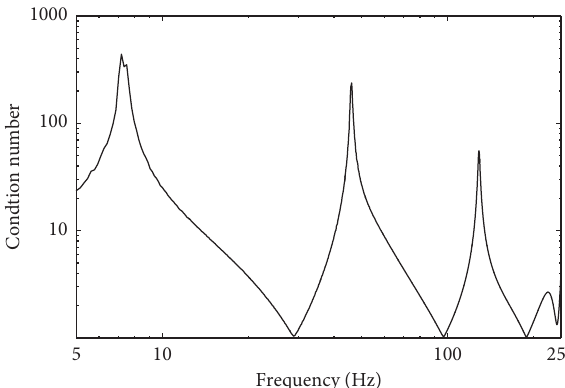
Figure 7: The condition number of FRF.